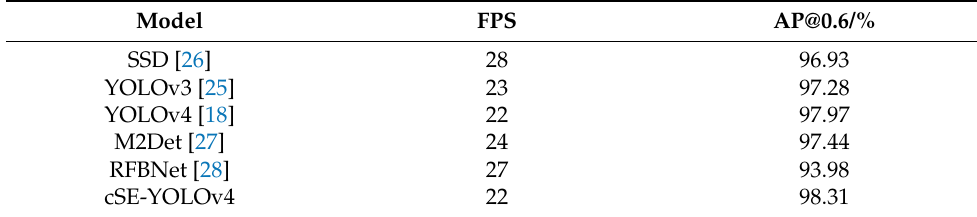
Table 2. Performance comparison of different algorithms.